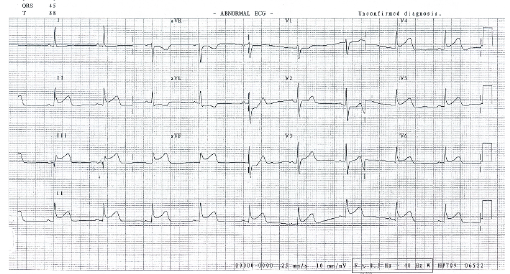
Figure 1: 12-lead ECG showing hyperacute phase of inferior wall myocardial infarction. ST segment elevation is seen in leads II, III, and AVF with upright T wave merging with the ST segment. ST elevation is also noticed in V5 and V6.